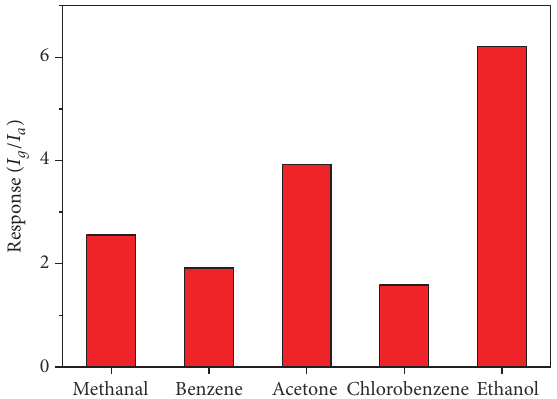
Figure 7: Comparison of the responses of the mesoporous SnO 2 nanowires to 100 ppm of different